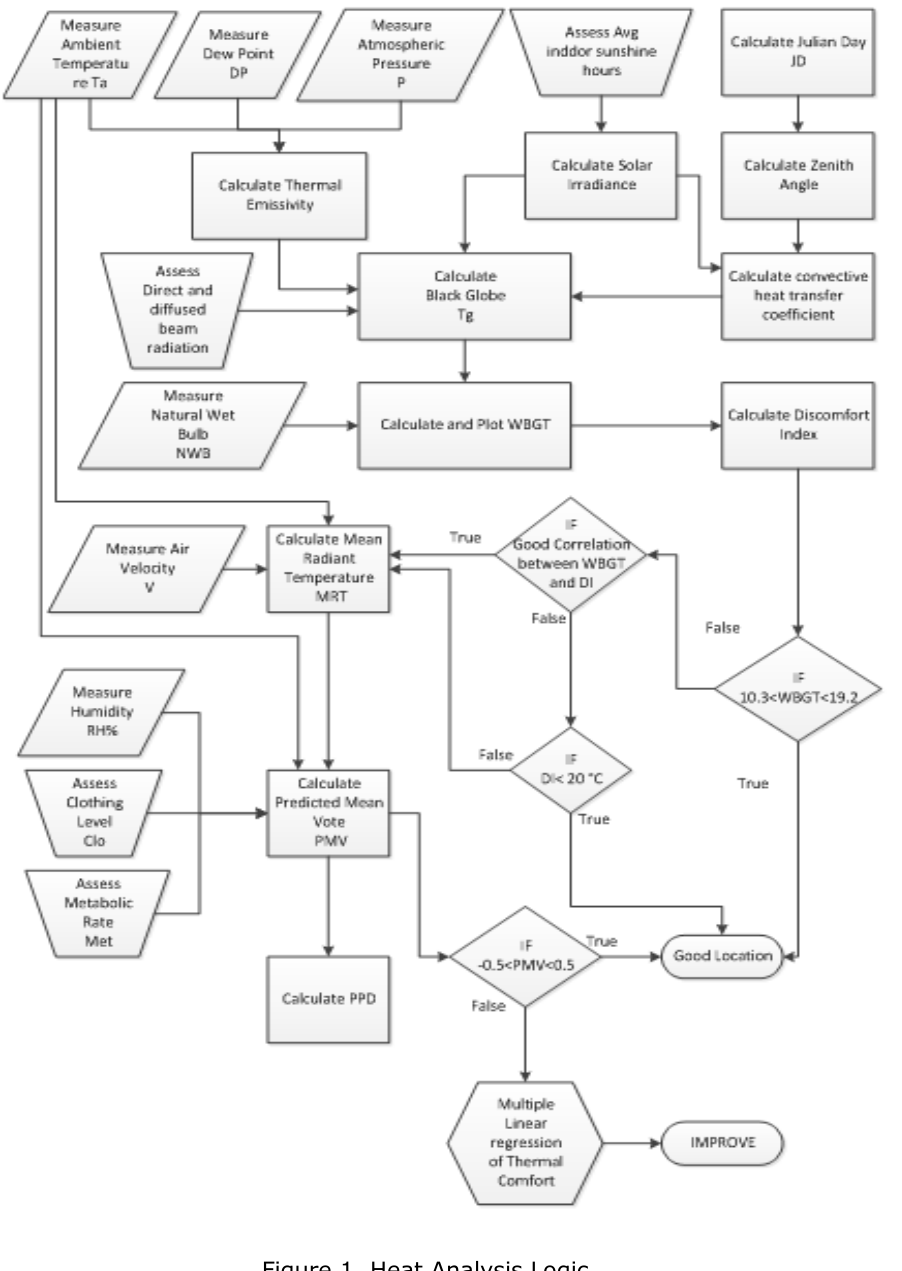
Figure 1. Heat Analysis